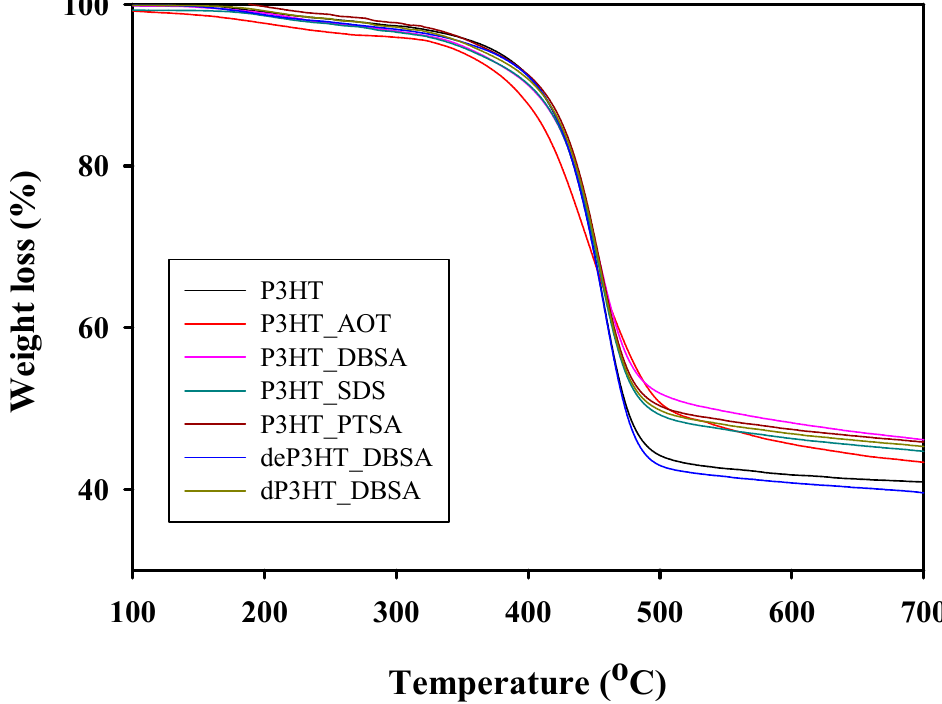
Figure 4. TGA thermograms of P3HT synthesized by chemical oxidative polymerization without and with various surfactants.